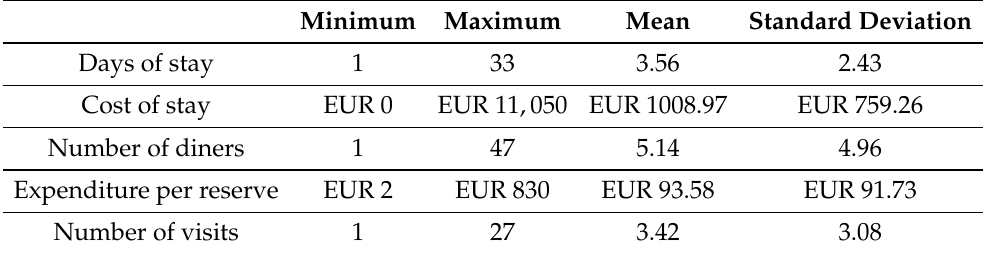
Table 2. Description of